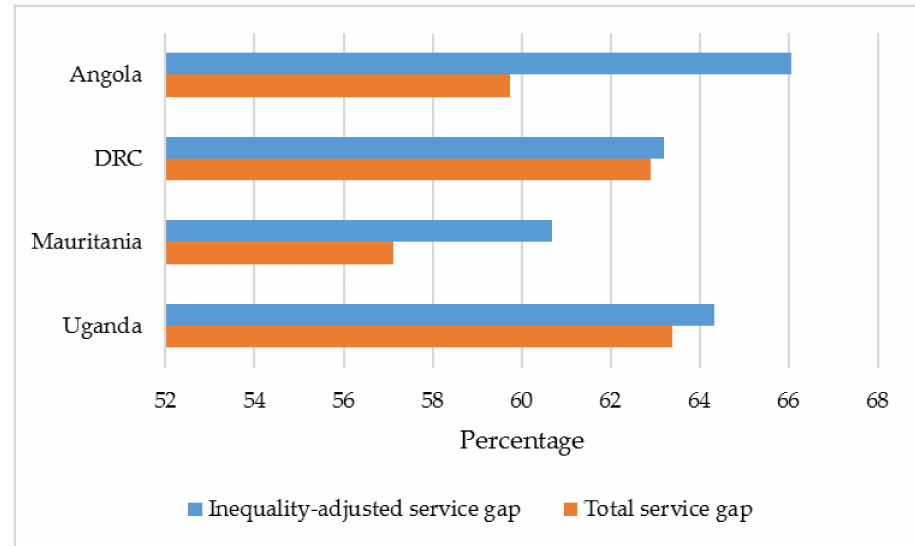
Figure 7. Comparison of the ‘total service gap’ and the ‘inequality-adjusted service gap’ for Uganda, Mauritania, Democratic Republic of Congo, and